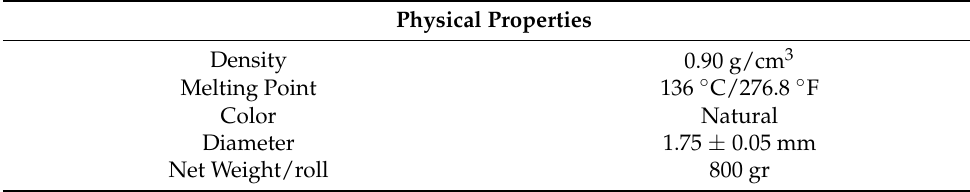
Table 1. Physical properties polypropylene filament supplied by Kreafil.